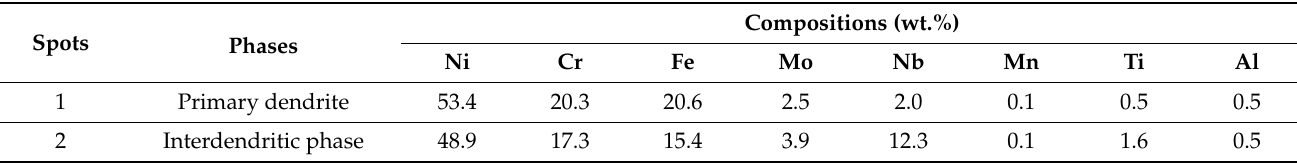
Table 1. Chemical compositions of primary dendrite and interdendritic phase in IN718 powder.